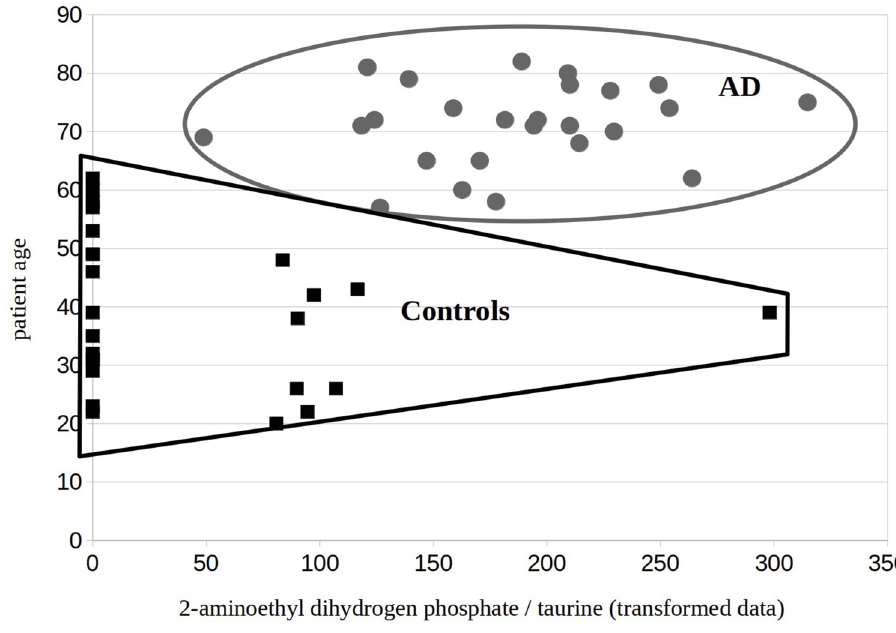
Fig 2. Scatter plot of patient age versus arcsin ratio of 2-aminoethyl dihydrogen phosphate / taurine). Squares are healthy controls (n = 25) and circles are Alzheimer’s patients (n = 25). The arcsin ratio does not correlate with age, however, the incidence of Alzheimer’s disease does increase with patient